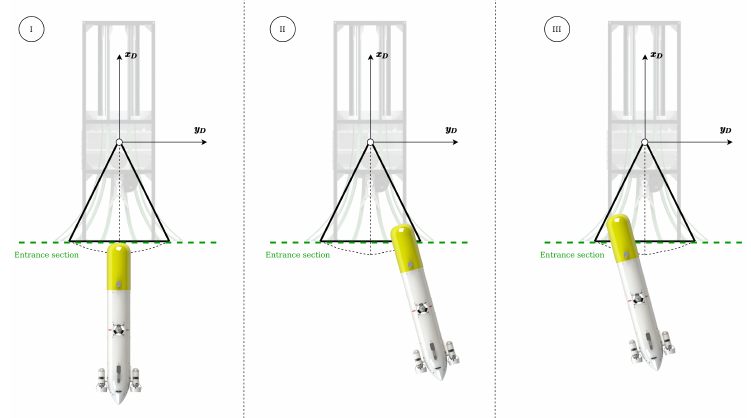
Figure 5. Successful entrance